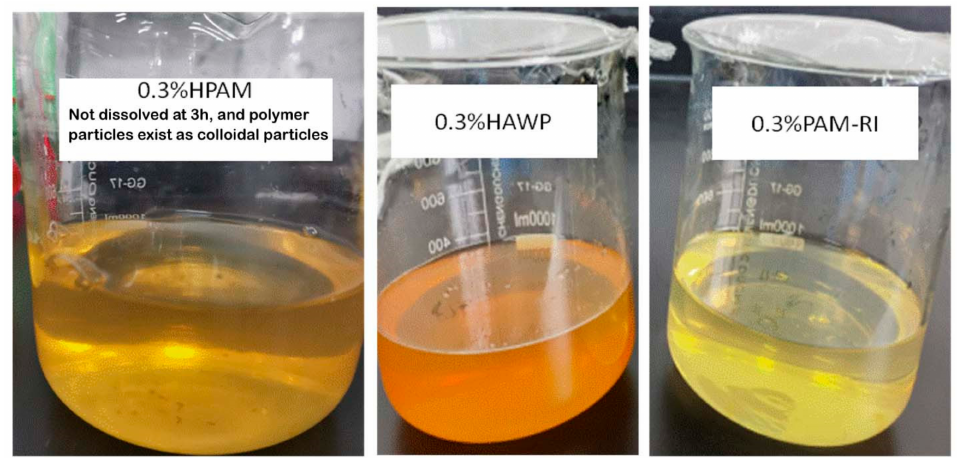
Figure 7. Changes in the simulated brine containing 50 mg/L Fe 2+ .